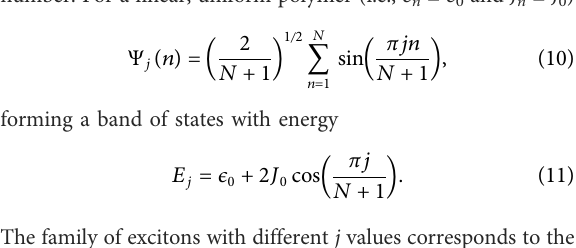
FIGURE 1 The mapping of a polymer chain conformation to a coarse- grained linear site model. Each site corresponds to a moiety along the polymer chain, with the connection between sites characterised by the torsional (or dihedral) angle, θ